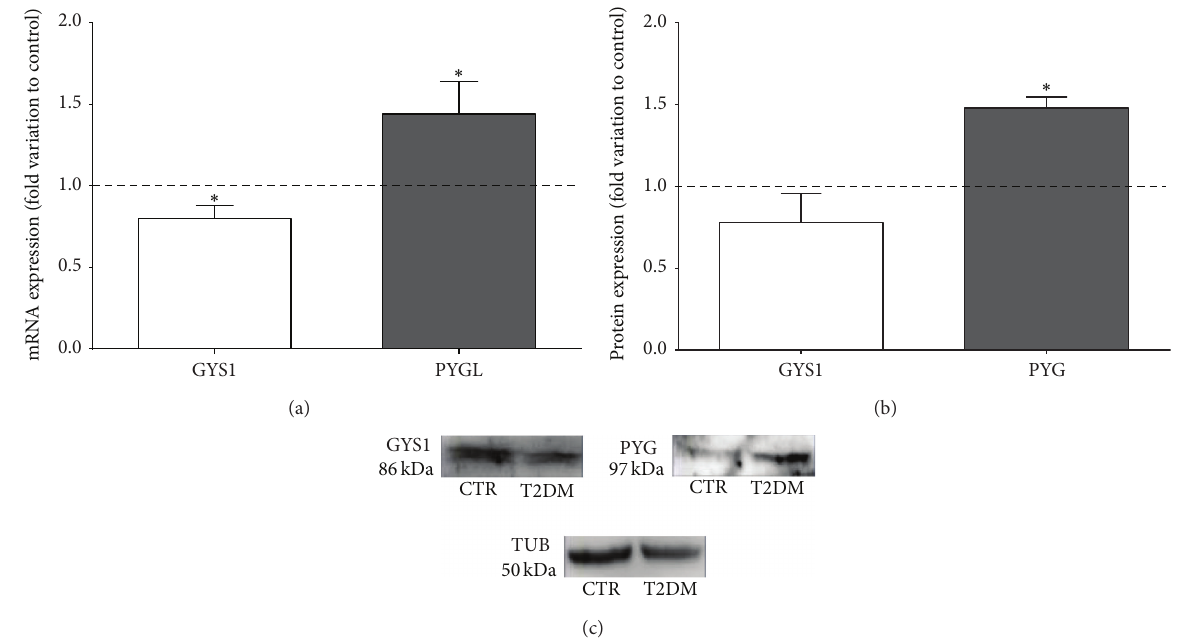
Figure 4: Type 2 diabetes mellitus (T2DM) modulates the expression of glycogen metabolism-related enzymes. (a) Pooled data of independent experiments, indicating the fold variation of glycogen synthase 1 (GYS1) and glycogen phosphorylase L (PYGL) mRNA levels found in testicles of T2DM rats when compared with the control rats (dashed line). (b) Pooled data of independent experiments, indicating the fold variation of GYS1 and PYG protein levels found in testicles of T2DM rats when compared with the control rats (dashed line). (c) Illustrative Western Blot experiment. Results are expressed as mean ± SEM ( 𝑛 = 6 for each condition). *Significantly different relative to control ( 𝑃 < 0.05